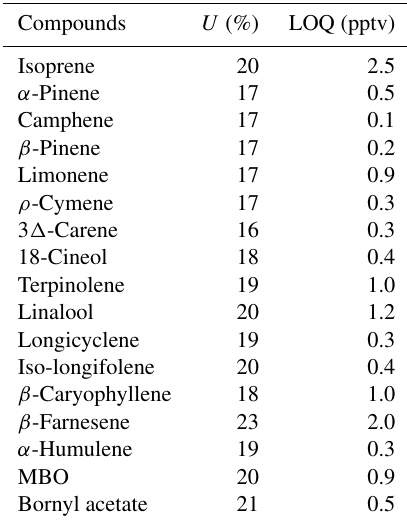
Table A2. The analytical uncertainty ( U ) for ambient temperature and the limit of quantification (LOQ) for the studied compounds. The estimation method is described in Helin et al. (2020).